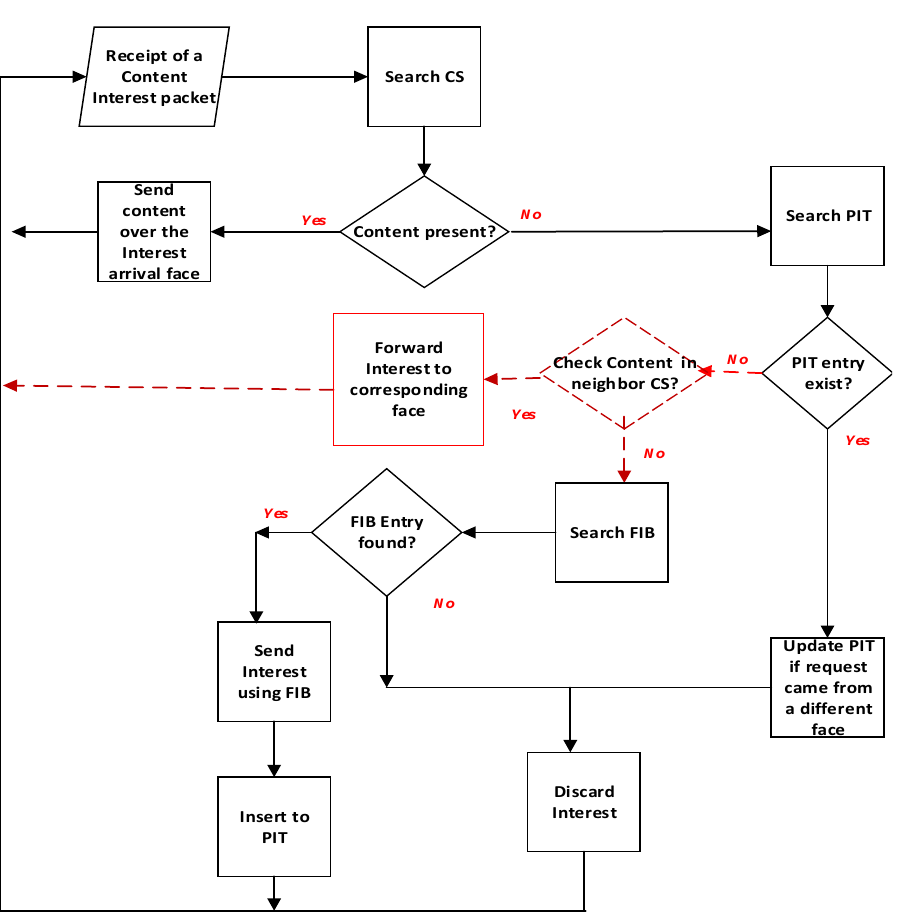
Figure 2. Forwarding engine of the proposed scheme compared to